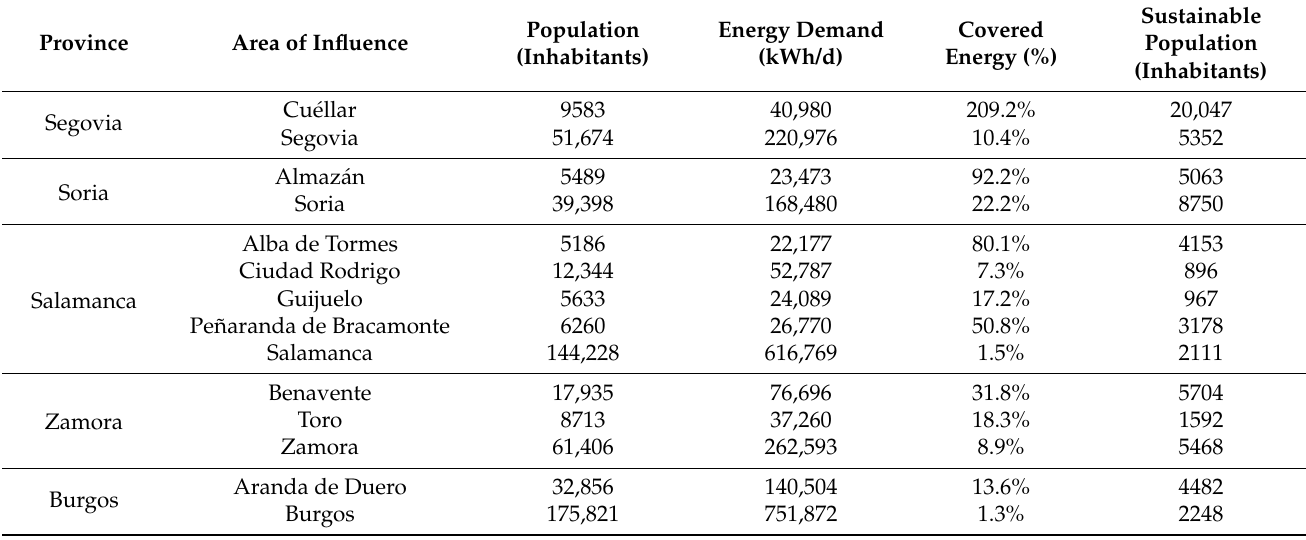
Table 2. Energy demand and covered energy of the selected municipalities, considering the energy demand of the residential